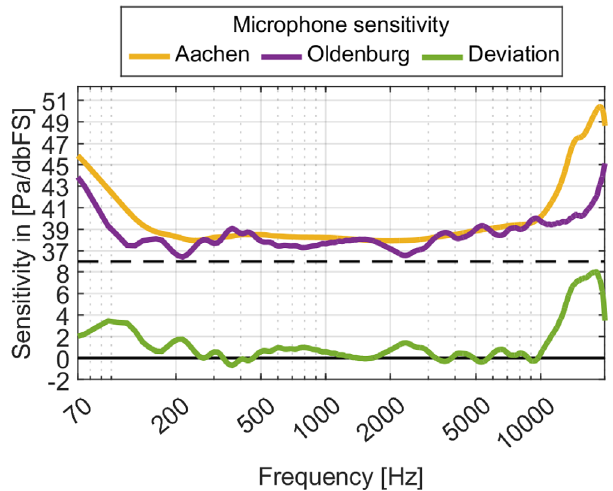
Figure 8. Transfer function of the microphone compensation in the post processing in Aachen and Oldenburg smoothed by a one-sixth octave band moving average window. The bottom part shows the deviation Aachen minus Oldenburg. Note that the y - axis is split into two